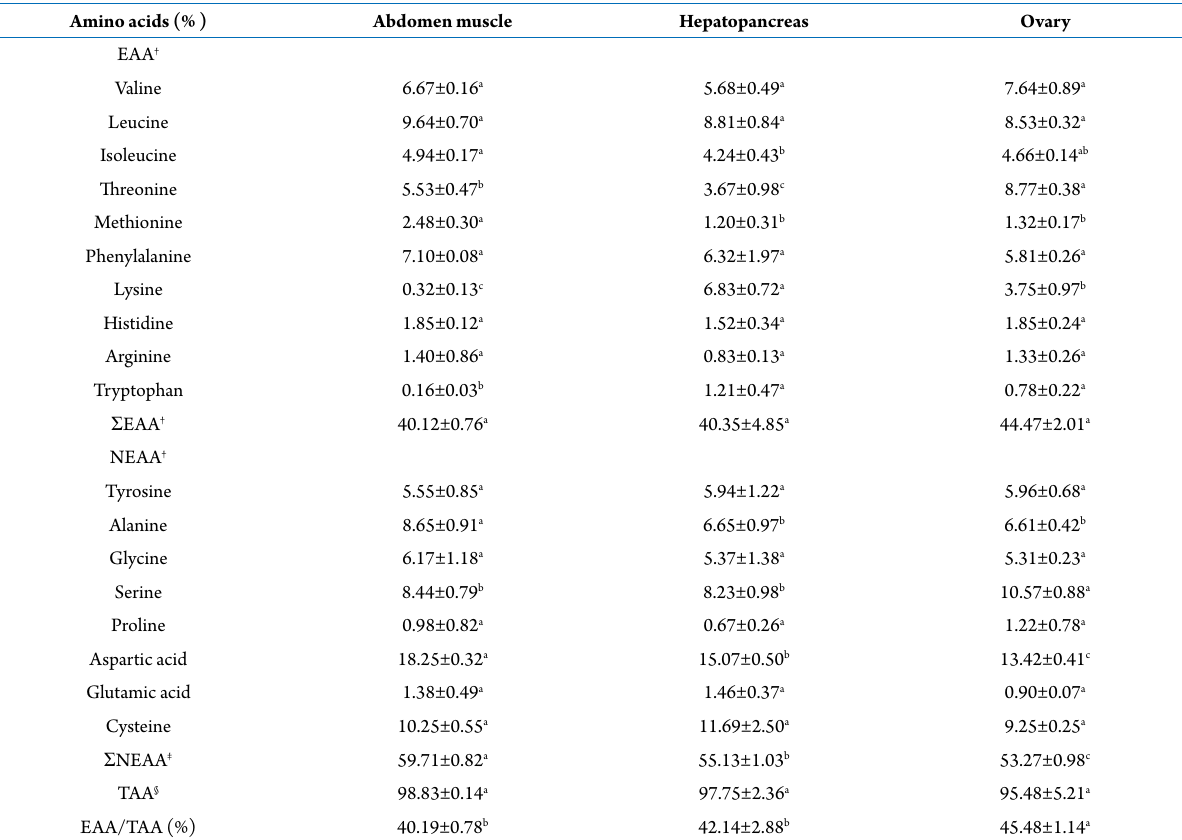
Table 3. Amino acid composition in the abdominal muscle, hepatopancreas, ovary (%, wet weight) during the reproductive season in female Pontastacus